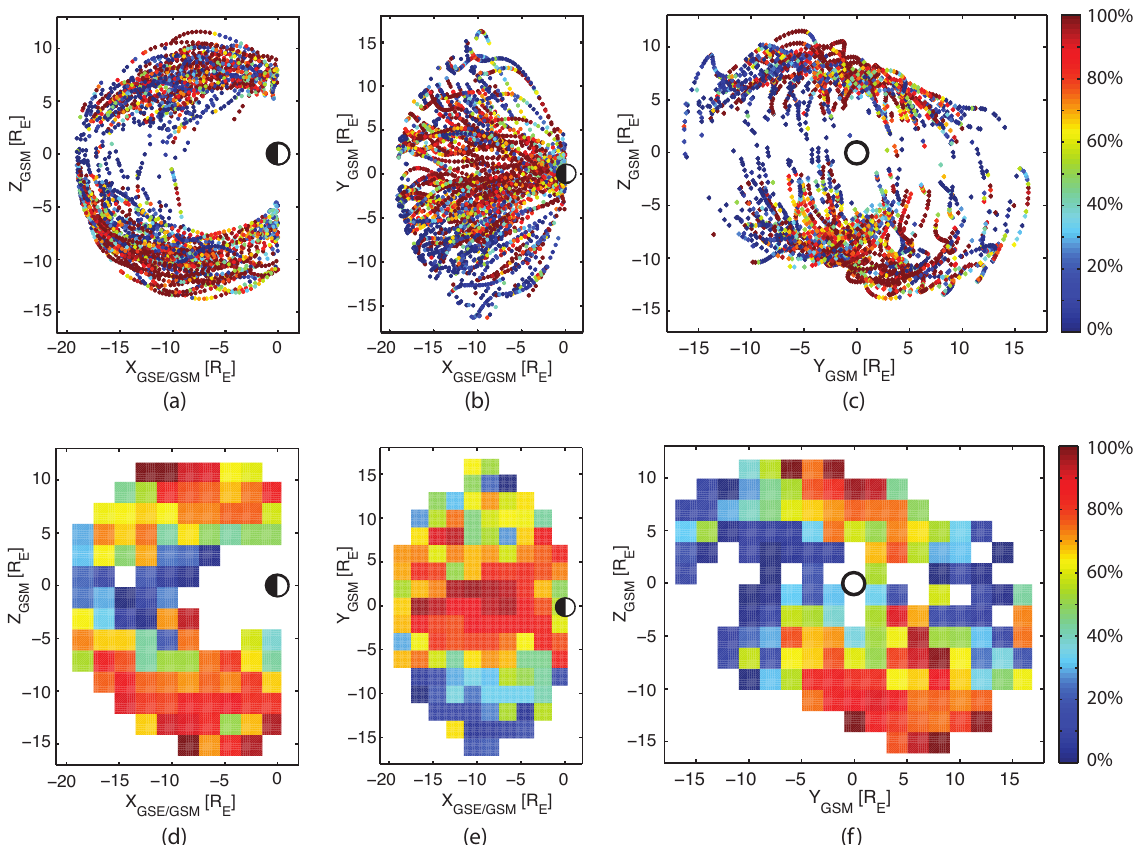
Fig. 3. Occurrence of cold ions. Detection of cold ions in the geomagnetic tail in the GSM X - Z , X - Y , and Y - Z planes. In the upper panel, each point corresponds to 30min of data. The colour shows the occurrence percentage of cold ions at the point. The lower panel shows the same data grouped in bins of 2 R E by 2 R E . A bin is coloured if it contains at least 1% of the mean number of points per bin. (The total data set consists of 765000